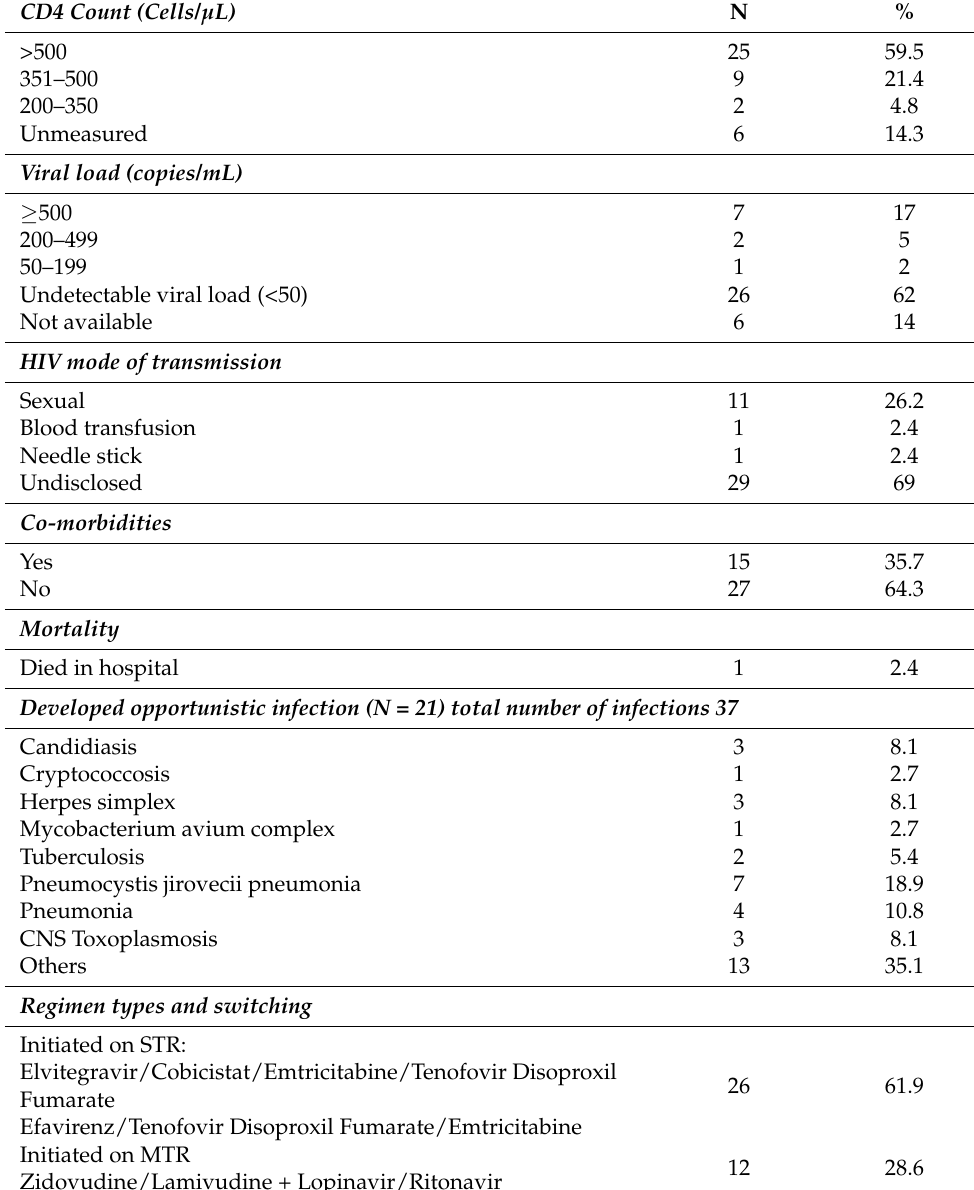
Table 2. Patients’ clinical characteristics and treatment